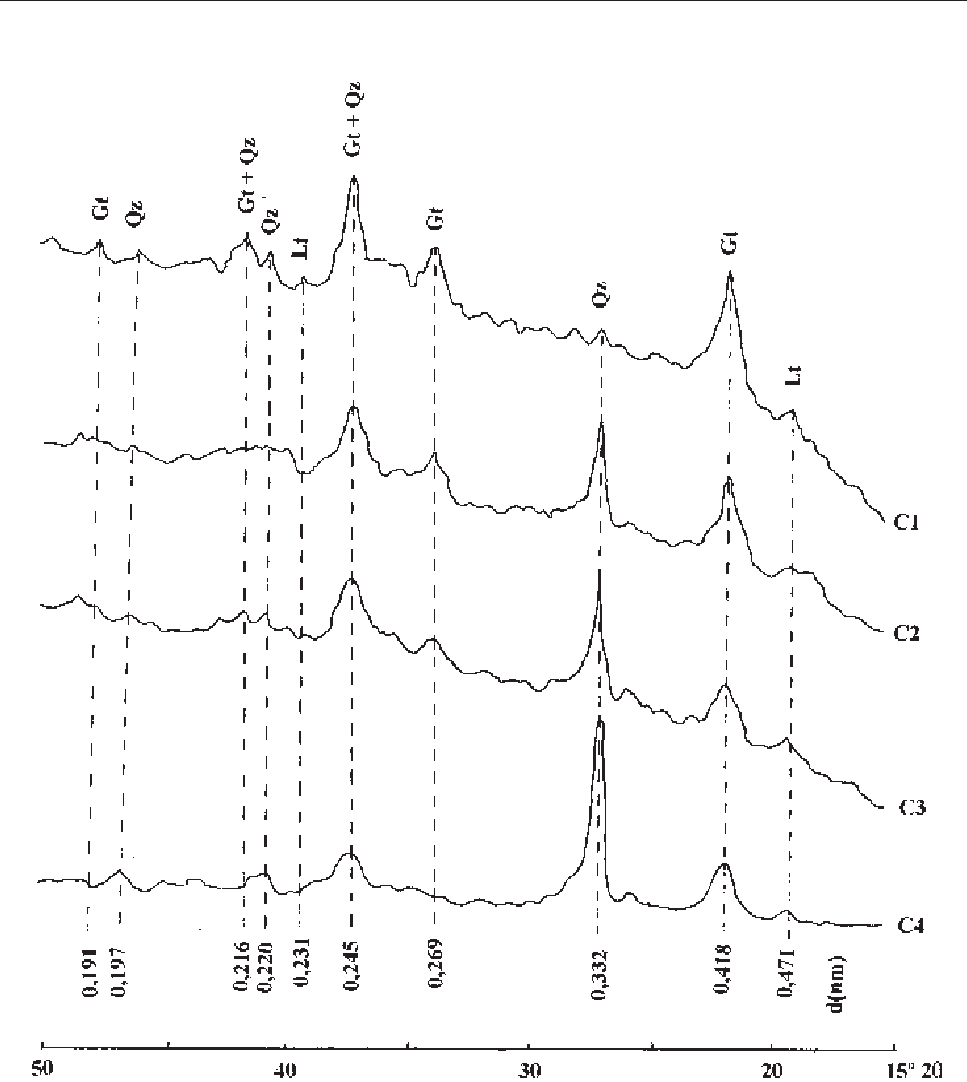
Figura 2. Difratogramas de raios-X das concreções de ferro e manganês trituradas, após concentração de óxidos de ferro (Gt - goethita; Qz - quartzo; Lt -